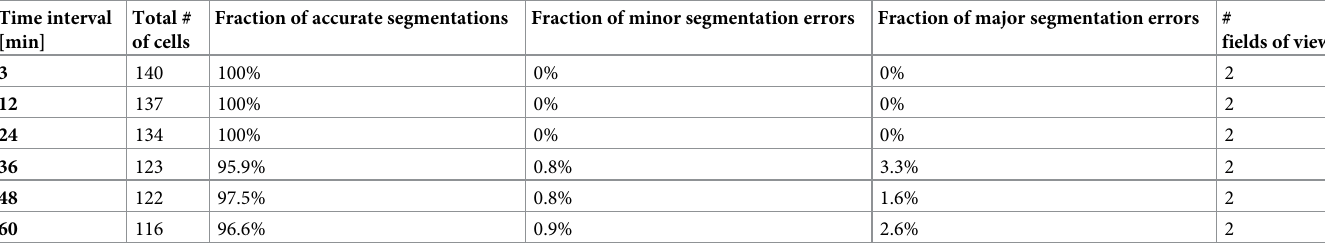
Table 4. Segmentation accuracy with respect to the time interval between